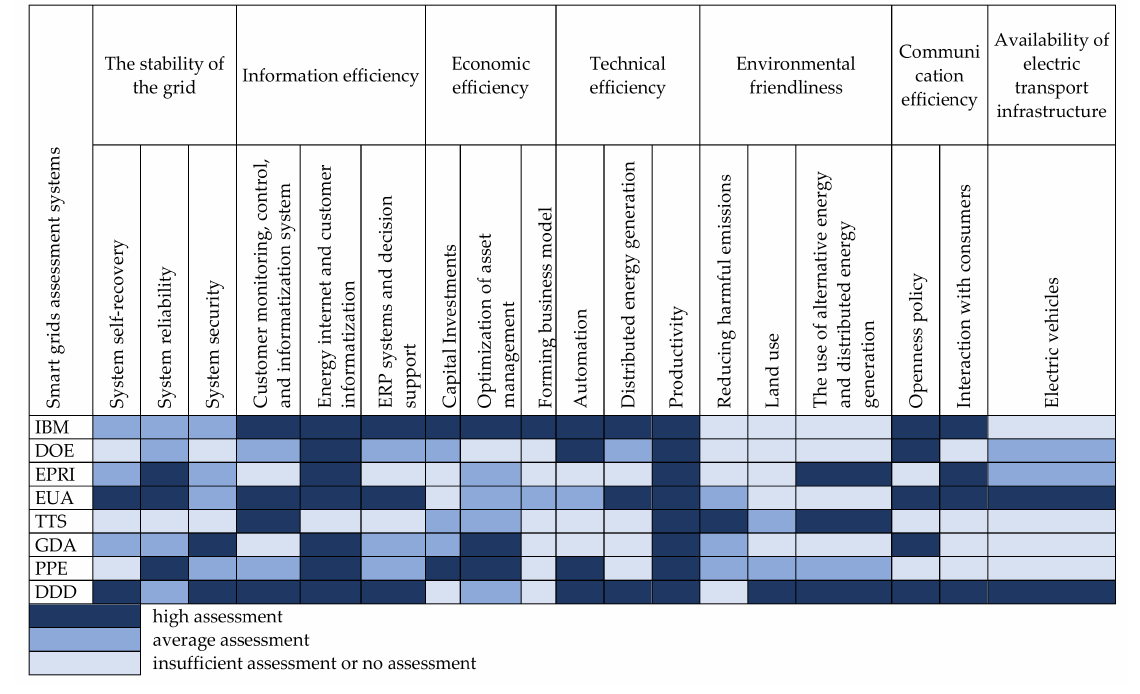
Figure 5. The summary comparative matrix of smart grid assessment systems. This matrix is formed based on the results of scoring according to the method described above (Table 3). Table 3. Quantitative evaluation of assessment systems by coverage of the smart grids’